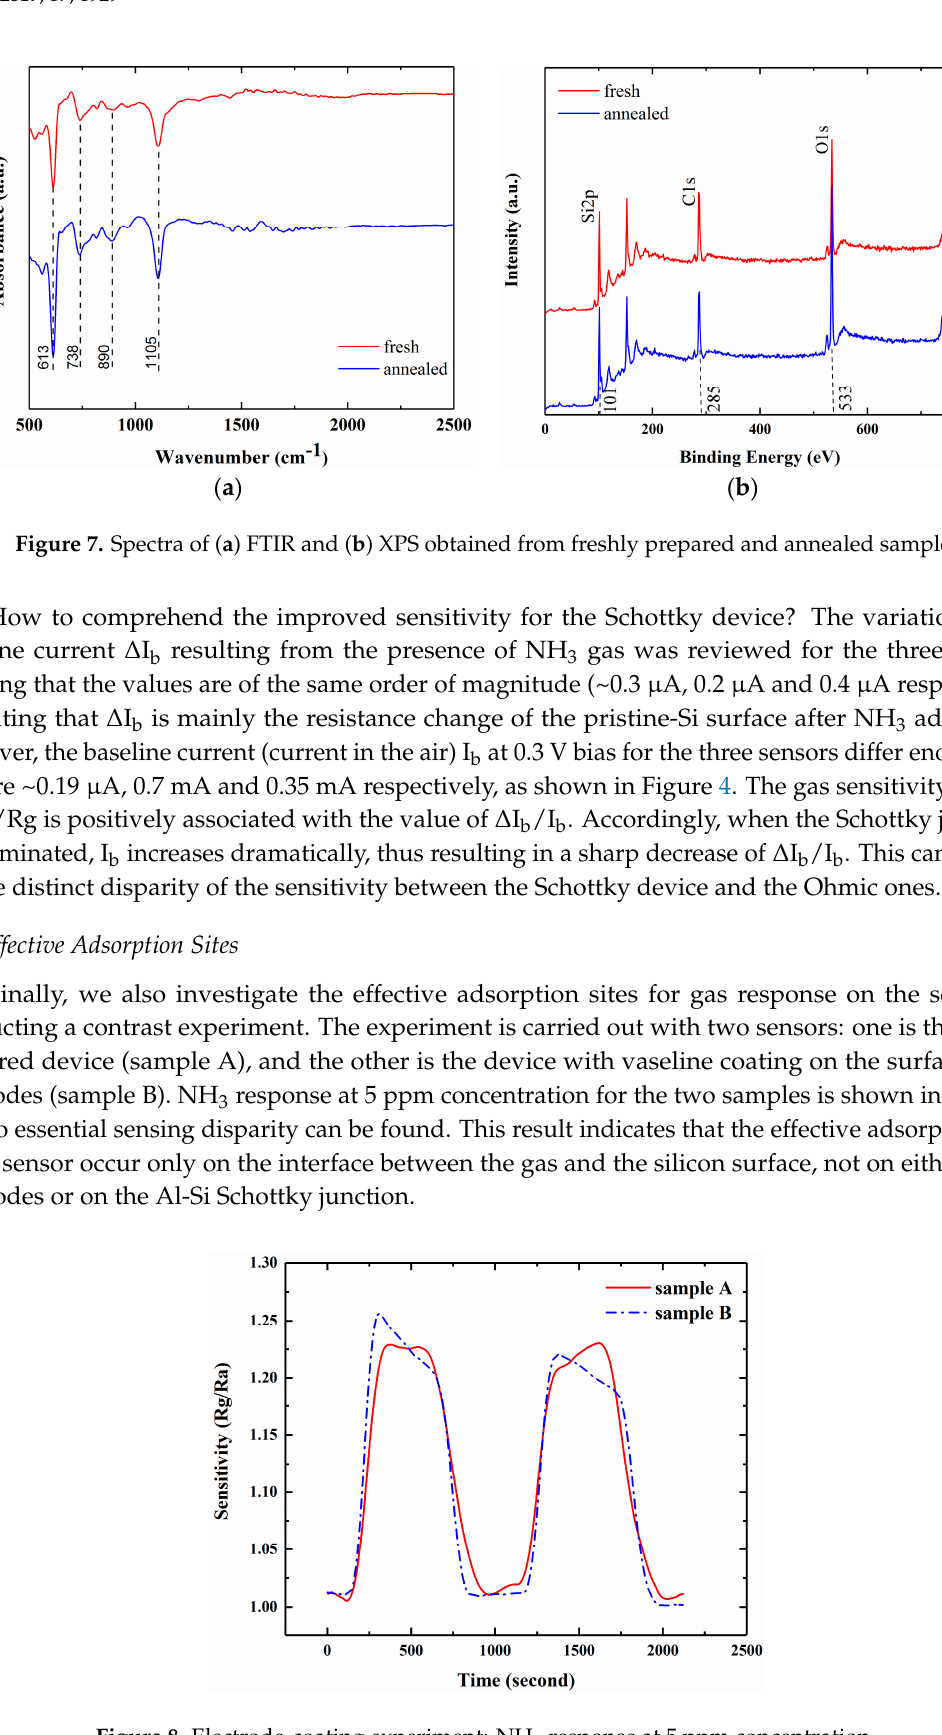
Figure 8. Electrode-coating experiment: NH 3 response at 5 ppm concentration.